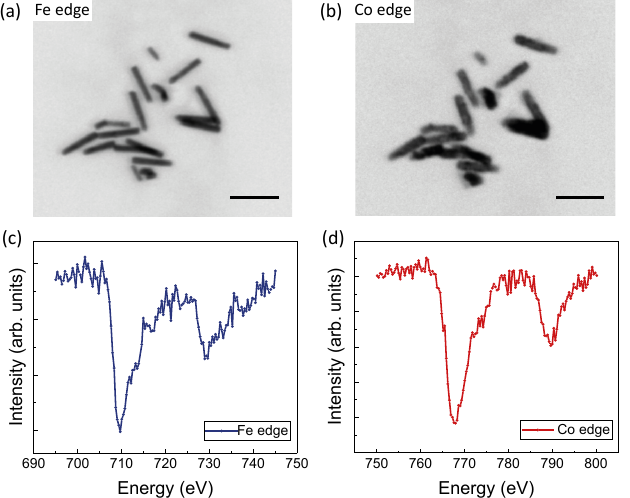
Figure 3. X-ray Transmission Microscopy characterization of the NWs. ( a , b ) Absorption images at the Fe L 3 and Co L 3 edges ( c , d ) and X-ray absorption spectra (XAS) of Fe and Co absorption edges of a cluster of FeNi/Au/Co NWs. The scale bar is 500 nm in both images.